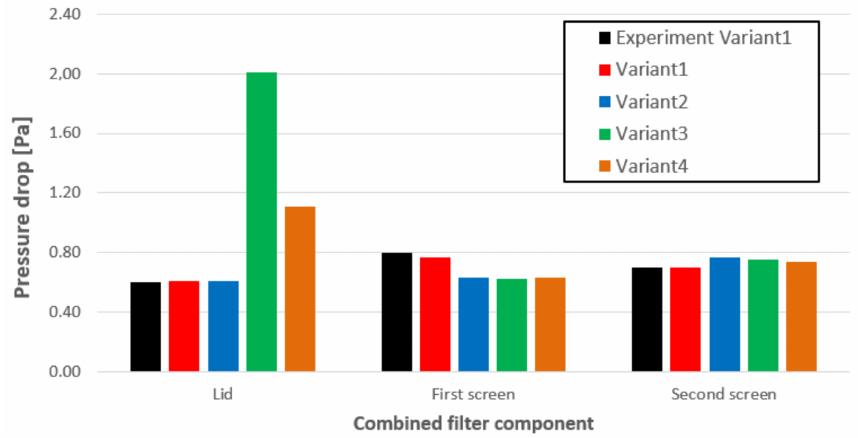
Figure 14. Pressure drop in components of combined filter at flow rate 70 L/s. Four variants of lid.